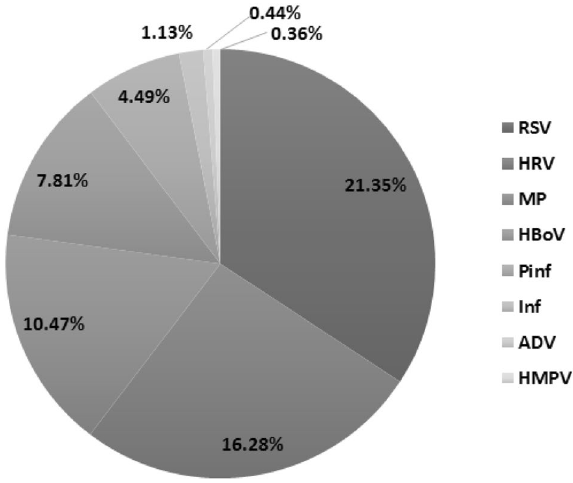
Figure 1. Distribution of pathogens in children with wheezing disease. RSV, respiratory syncytial virus; HRV, human rhinovirus; MP, mycoplasma pneumoniae; HBoV, human bocavirus; Pinf, parainfluenza virus; Inf, influenza virus; ADV, adenovirus; HMPV, human metapneumovirus. Figures were generated using Adobe Illustrator version CC 2018 (https:// www. adobe. com/ cn/ produ cts/ illus trator. html).